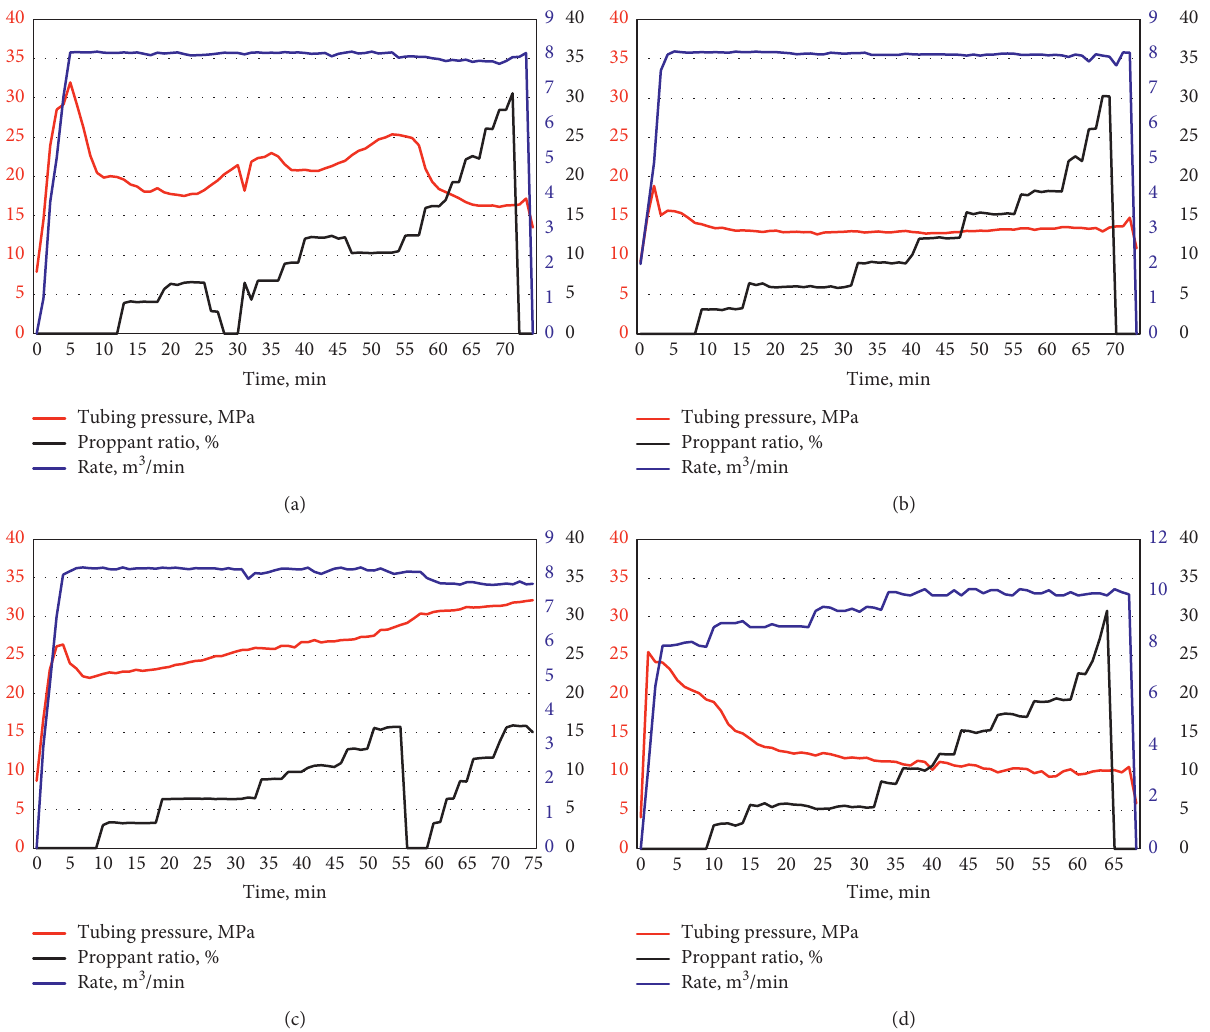
Figure 4: The pattern of the vertical hydraulic fracture shapes. (a1) Short-wide fracture. (b1) Long-Narrow fracture. (c1) Multiple-narrow fracture. (d1) High-short fracture. (a2) Short-wide fracture. (b2) Long-narrow fracture. (c2) Multiple-narrow fracture. (d2) High-short